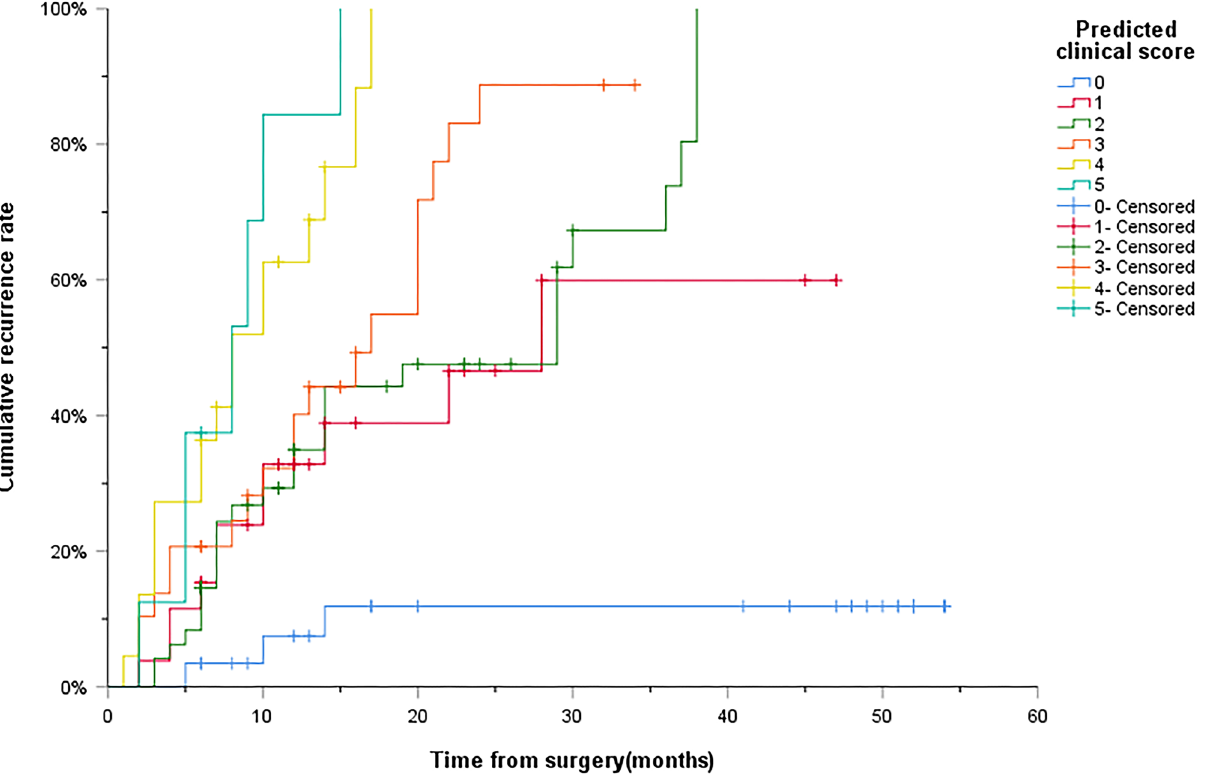
Figure 5. Preoperative clinical score 0 to 5 scores to predict the cumulative recurrence rate curve of HCC after RFA. RFA Radiofrequency ablation; HCC Hepatocellular